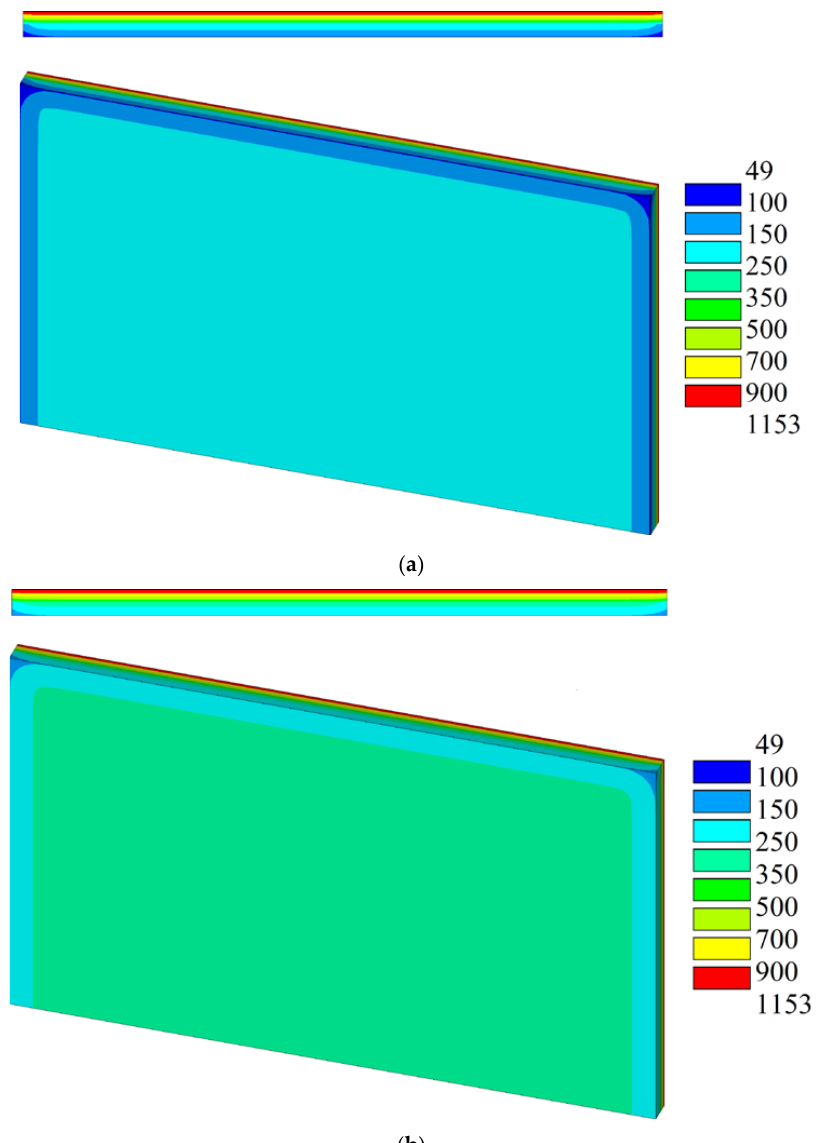
Figure 12. Analysis results for the W1A specimen and two values of material thermal conductivity: ( a ) 0.50 W / m K; ( b ) 1 W / m